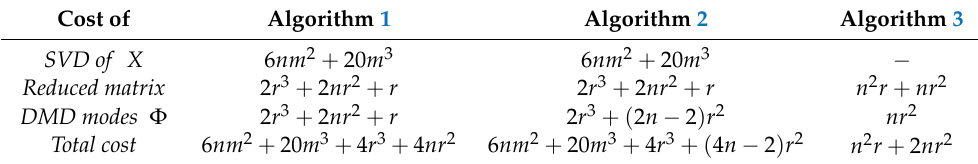
Table 2. Computational costs.